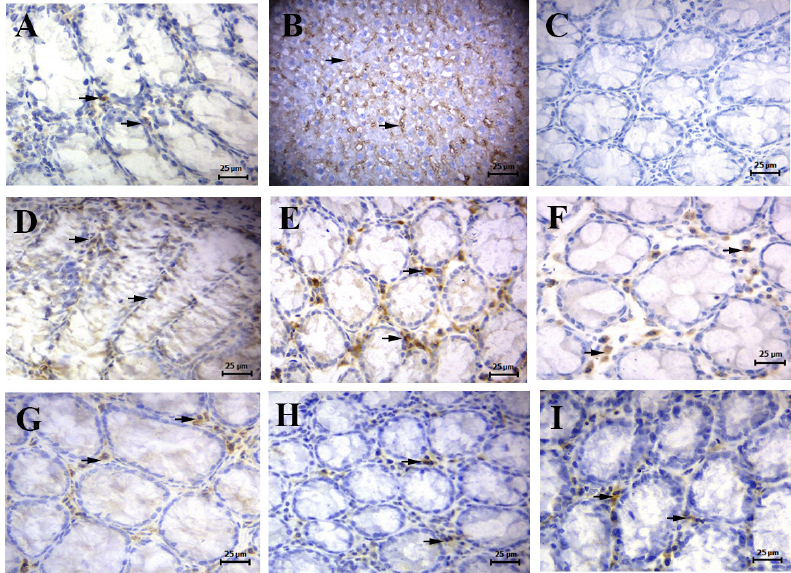
FIGURES 4 - Immunohistochemical staining of mice colonic tissue using Cox-2 antibody (brown, arrows) in different groups. All slides were counterstained with hematoxylin. A: Normal control, B: Positive control, C: Negative control, D: AOM